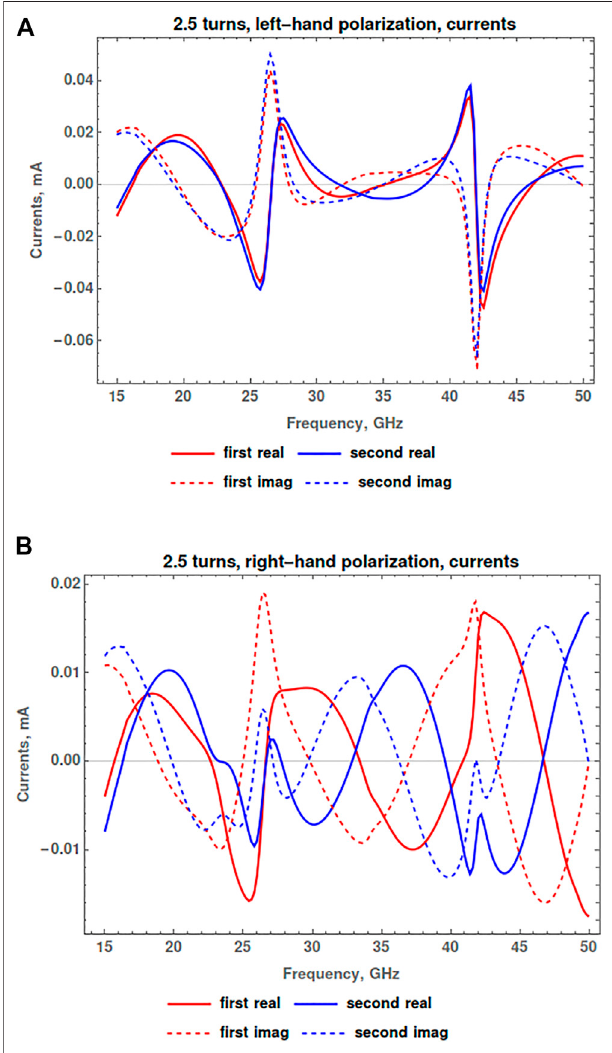
FIGURE 3 | (A) Dependence of the real and imaginary parts of the electric currents in two strands of the DNA-like helix in the fi eld of an incident wave with left-hand circular polarization on the wave frequency (the case of strong interaction between the wave and the helix). (B) A similar dependence for currents if the helix is in the wave fi eld with right-hand circular polarization (the case of weak interaction between the wave and the